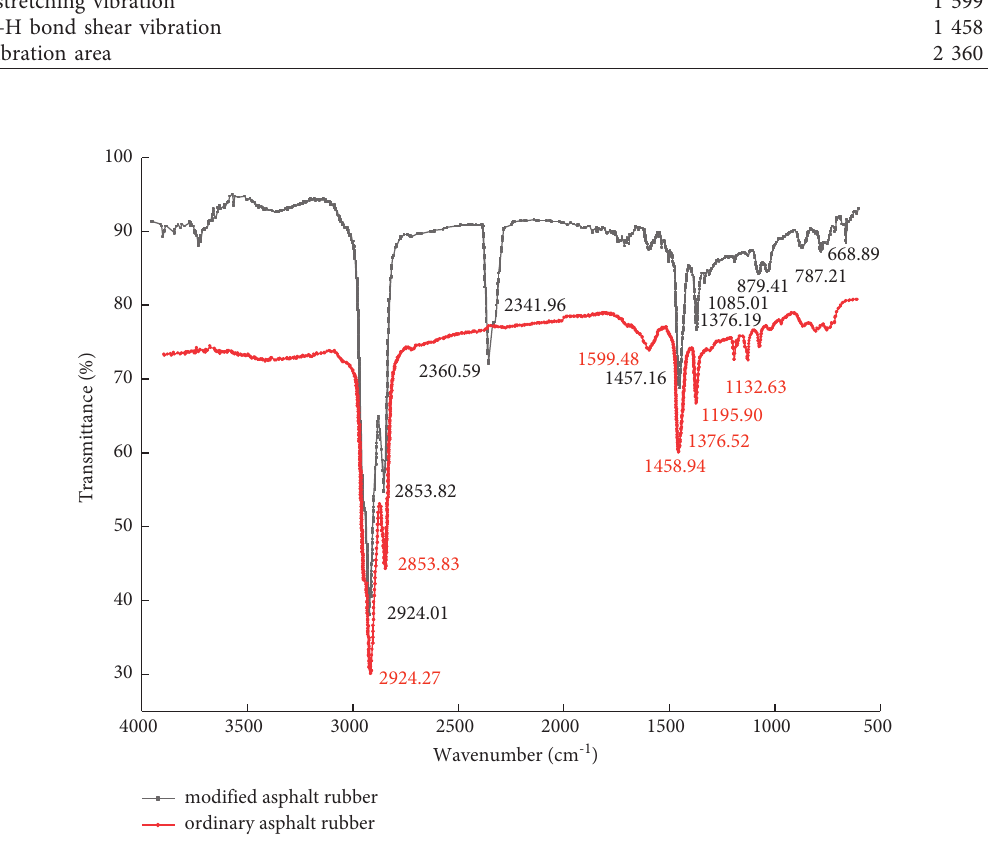
Figure 5: Infrared spectrum test results.